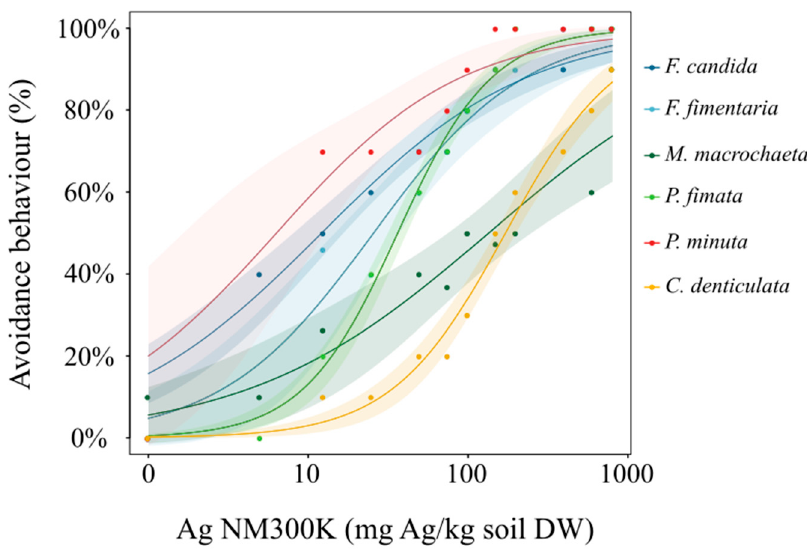
Figure 2. Avoidance behaviour for the different collembolan species when exposed to Ag NM300K (mg Ag NM300K/Kg soil DW) in LUFA 2.2 soil. Solid line represents the fitted model, the light section is the 95% confidence interval. Table 2. Avoidance effect concentrations (EC x , mg Ag NM300K/Kg soil DW) for the different